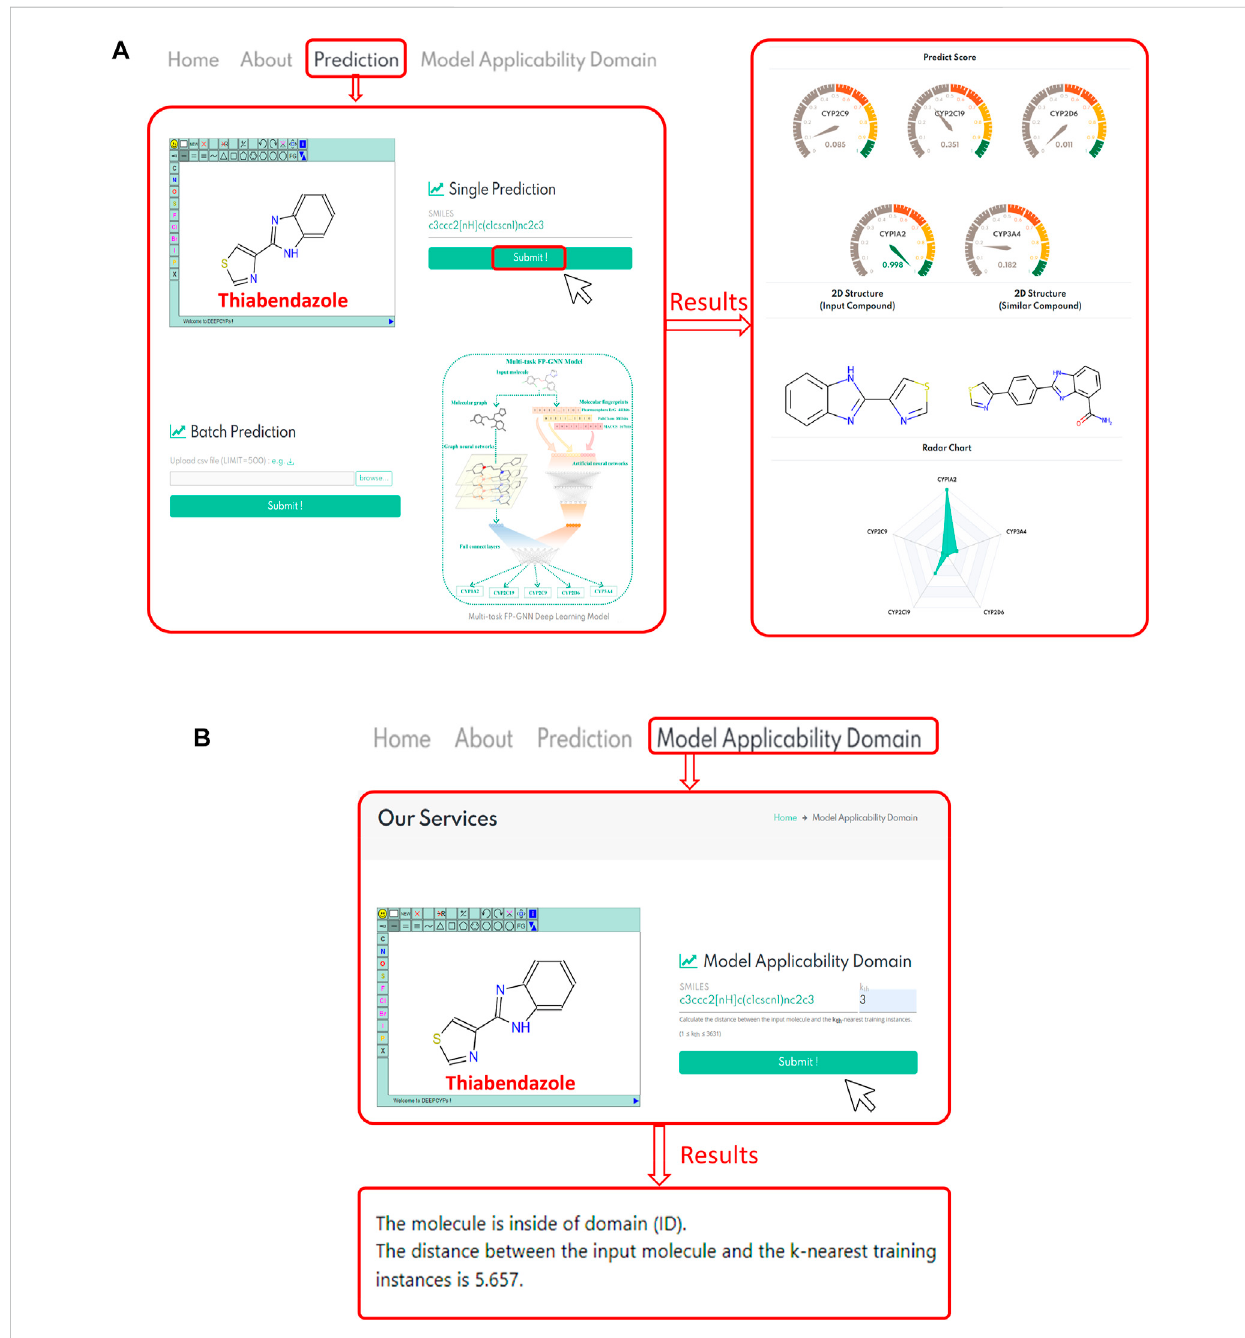
FIGURE 6 (A) Represents the bioactivity prediction diagram of theDEEPCYPs. (B) Represents acase result display of themodel applicability domain module of the DEEPCYPs. The chemical structure of thiabendazole is used as an